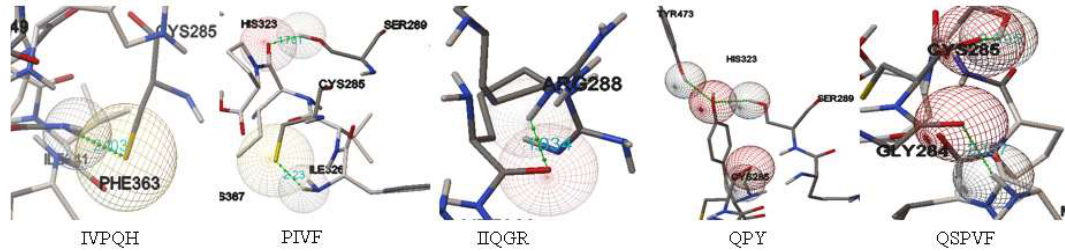
Figure 2. Intermolecular bonds of ligand–receptors.